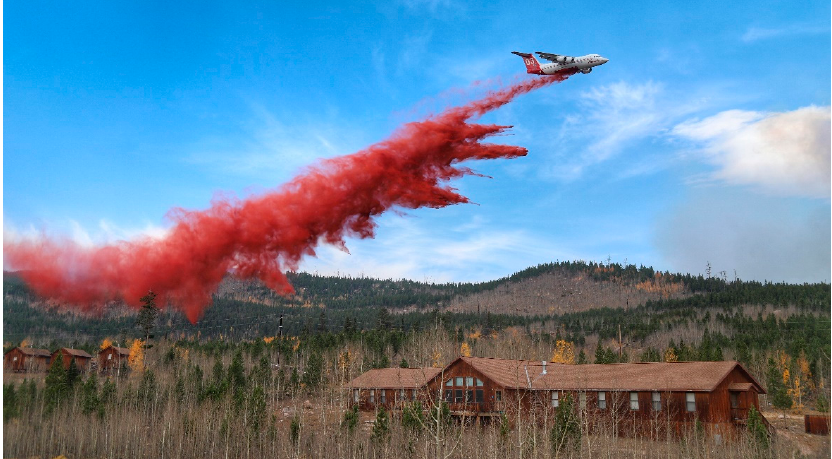
Figure 2. An aerial suppression plane dropped fire retardant along the fire-line just west of the Colorado State University Mountain Campus north dorm. Although the flames crossed the main fire-line, suppression efforts were successful and protected the residential and guest cabins.